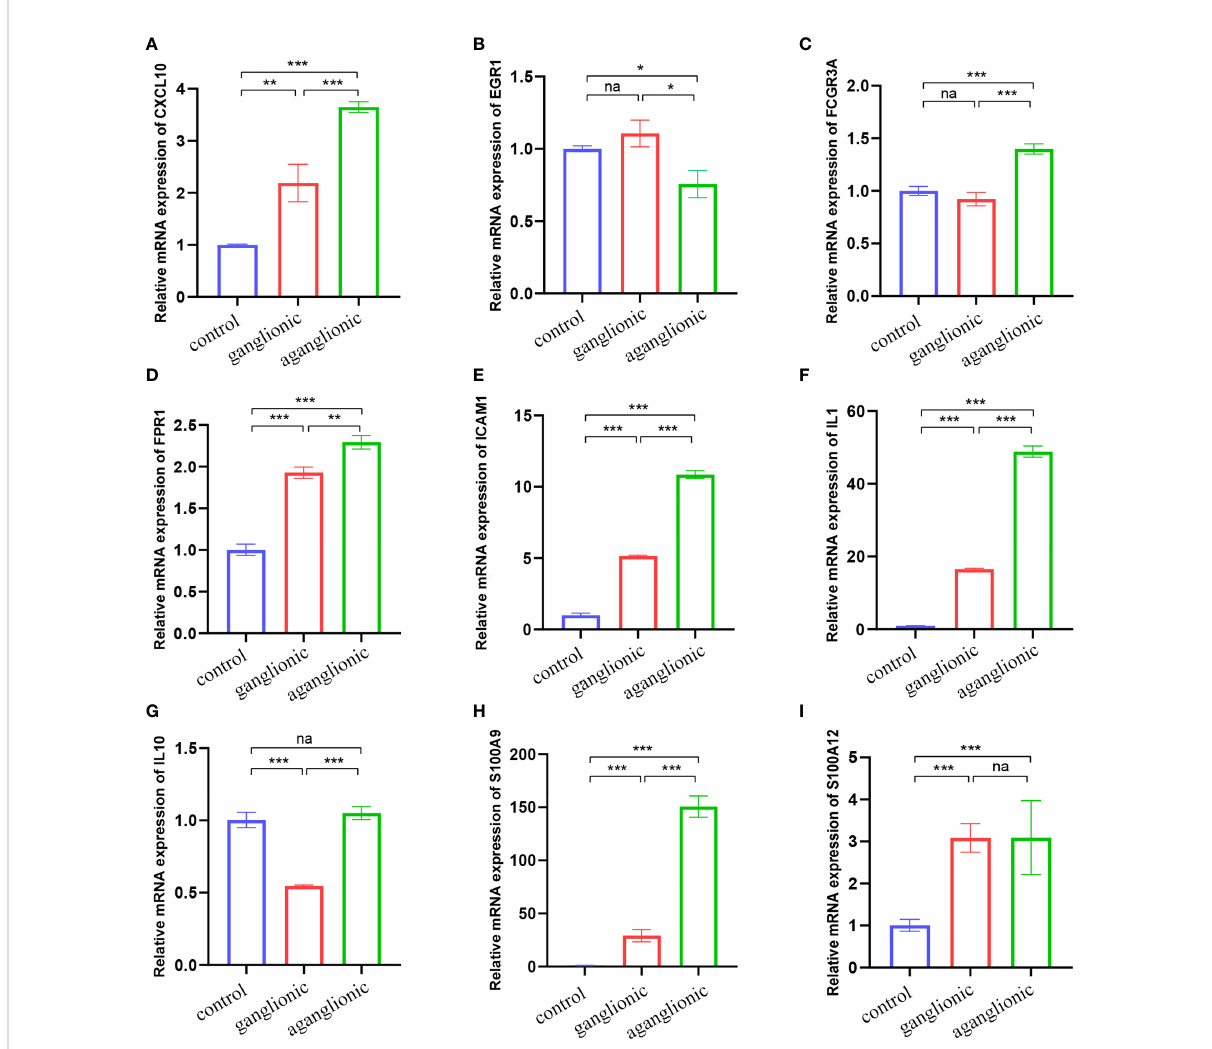
FIGURE 6 Validation of the nine hub genes ’ expression in HSCR and normal colon tissue samples by RT-qPCR (n = 10). (A) CXCL10, (B) EGR1, (C) FCGR3A, (D) FPR1, (E) ICAM1, (F) IL1B, (G) IL10, (H) S100A9 and (I) S100A12. Na, not signi fi cant; HSCR,Hirschsprung disease. *, p < 0.05; **, p 0.01; ***, p